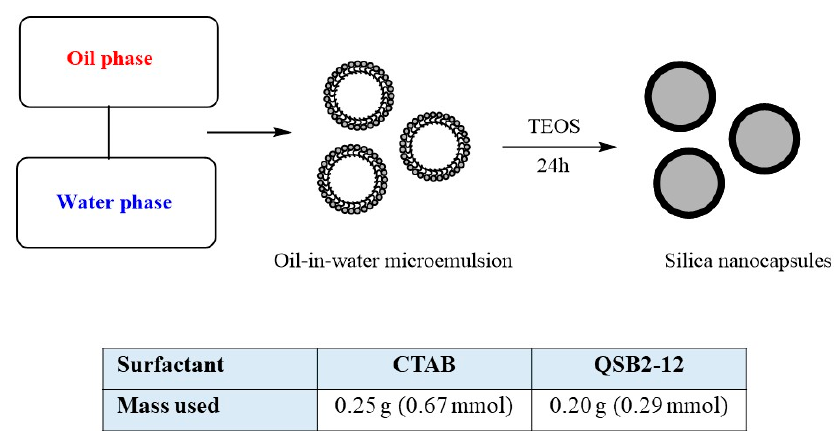
Figure 2. Scheme for the silica nanocapsules synthesis and a quantity of surfactants used.